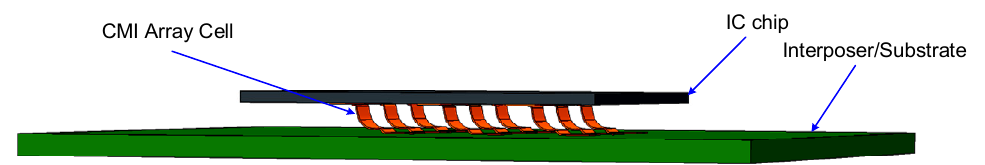
Figure 12. The schematic of a 3 × 3 CMI array.